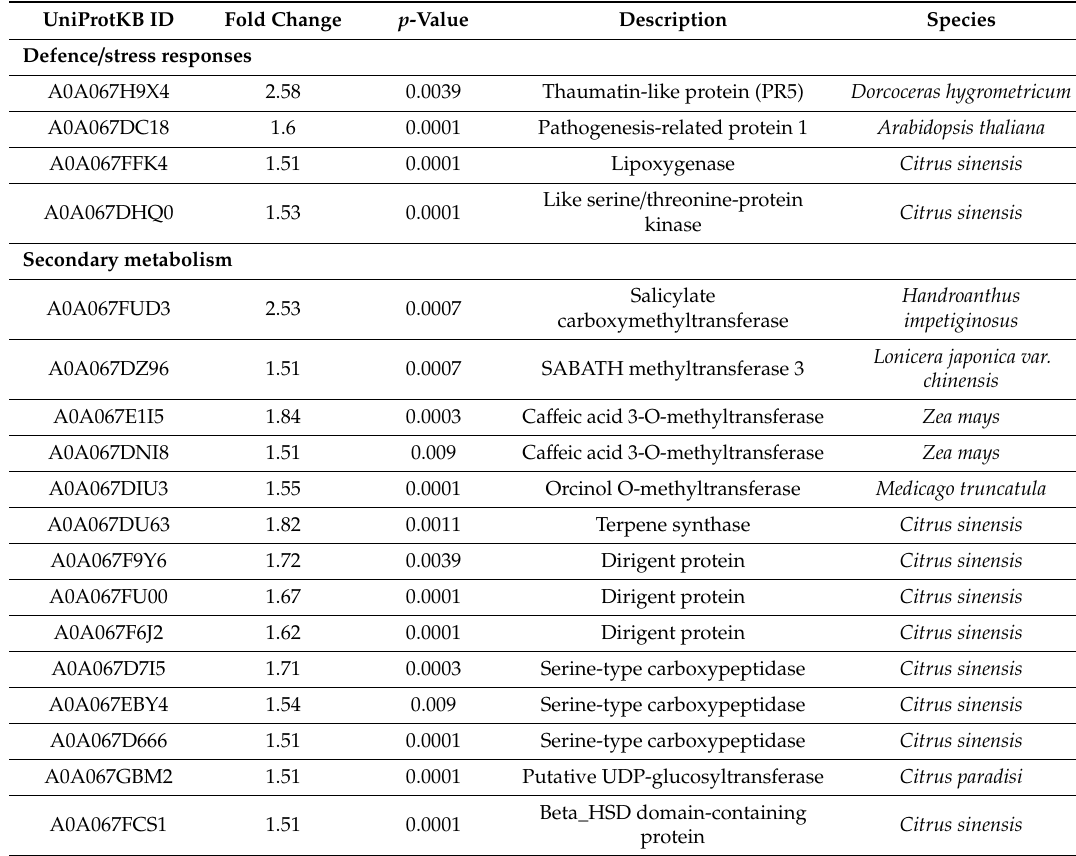
Table 2. Up-regulated proteins involved in defence responses and secondary metabolic pathways in midribs of HLB-infected citrus seedlings cultivated in amended soil conditions. The detailed information of all di ff erent expression proteins (DEPs) is listed in Supplementary Table